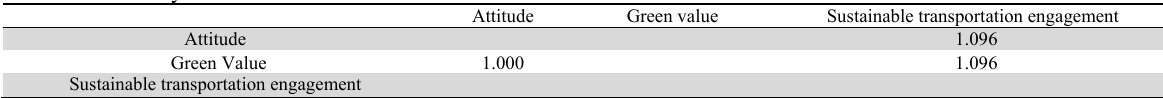
Lateral collinearity